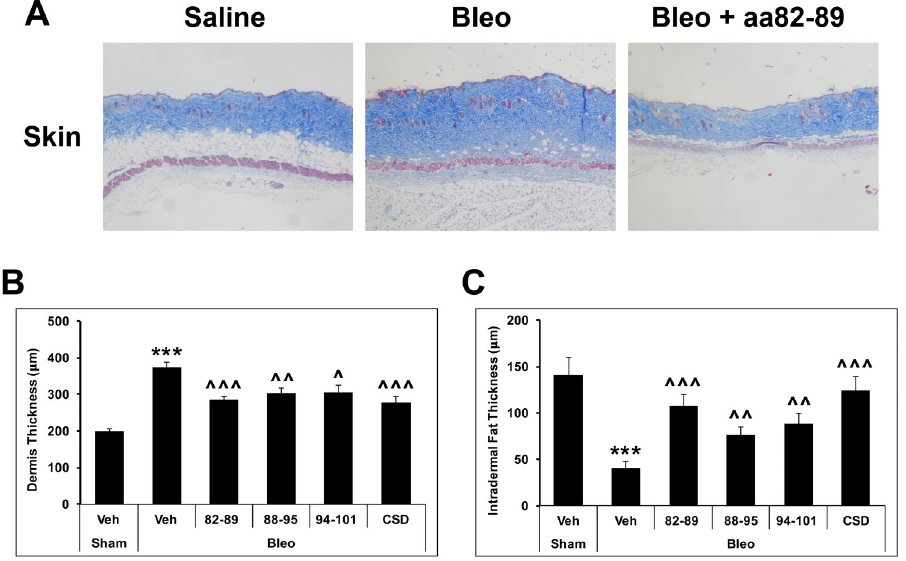
Fig 3. Inhibition of bleomycin-induced dermal fibrosis and thinning of the transdermal fat layer (lipoatrophy) by subregions of CSD. The same mice used in Fig 1 were used here. After sacrifice, the thickness of the dermis and intradermal fat layer in tissue sections were measured (six mice per condition). (A) Masson’s Trichrome-stained skin tissue sections demonstrate the dermal fibrosis and lipoatrophy caused by bleomycin and its reversal by 82–89. (B) Quantification of dermal fibrosis. (C) Quantification of lipoatrophy. ��� p < 0.001 vs Saline control; ^^^p < 0.001, ^^p < 0.01, ^p < 0.05 vs Bleo control.